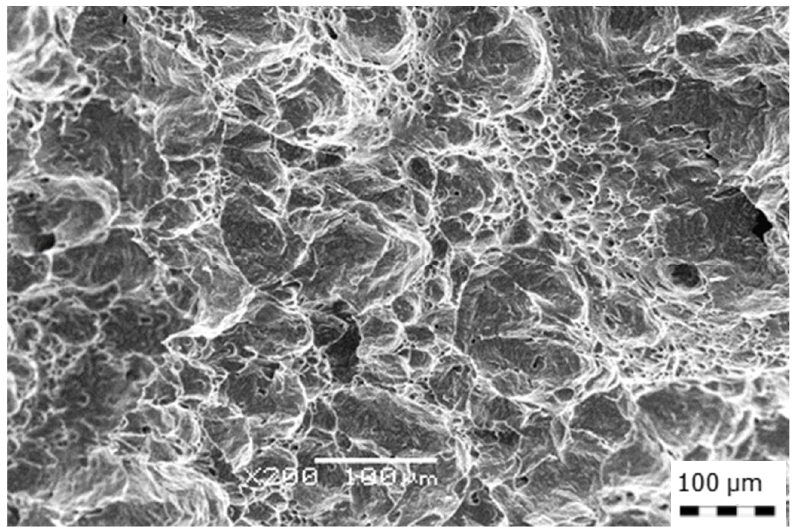
Figure 14. Fracture surface of hot-rolled